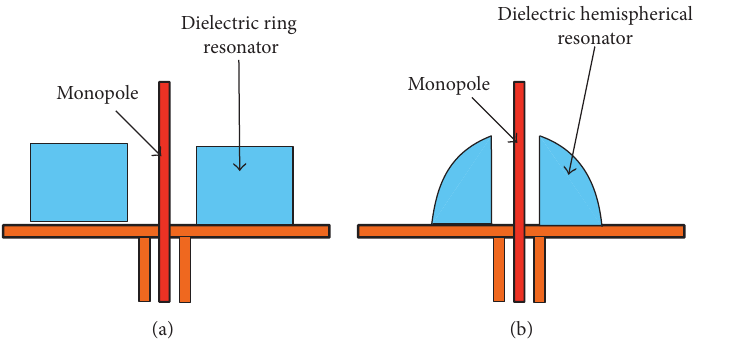
Figure 24: Circular aperture slot (a) as introduced in [53] and U-shaped slot (b) as investigated in [54].